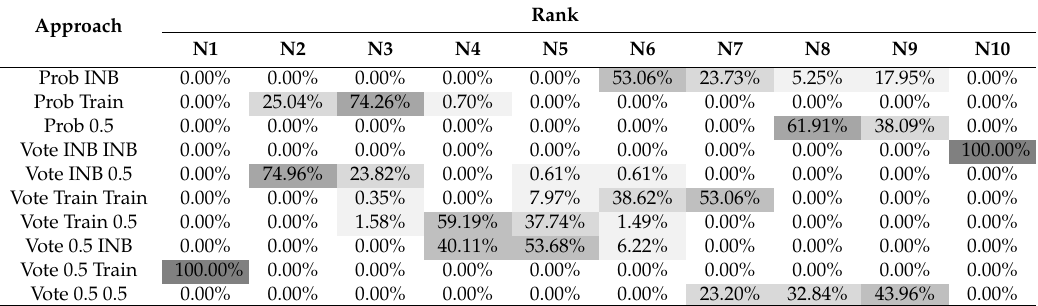
Table 6. Distribution of global ranks for probability assignment in terms of the score observed on the validation